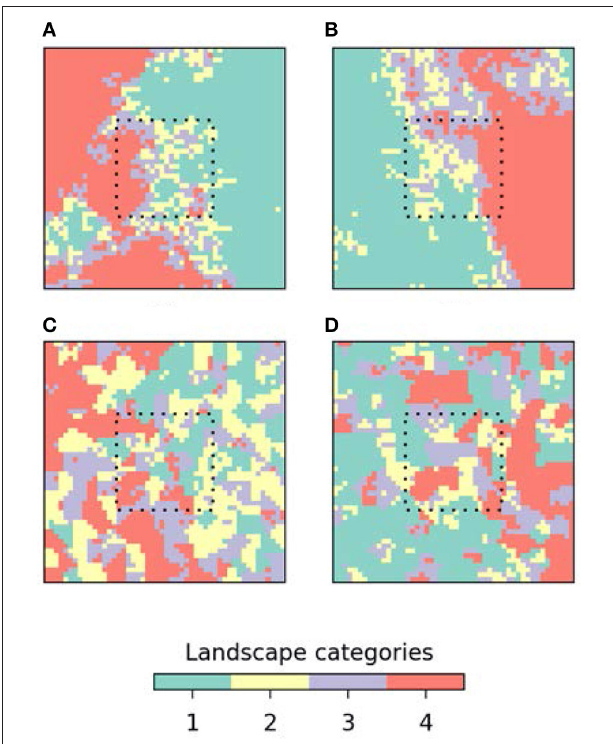
FIGURE 2 | Examples of neutral landscape models of prehistoric landscapes for a hypothetical pollen record indicating four landscape categories. (A,B) Different realizations of naturalistic landscapes in which landscape categories are an ordered sequence resulting from a natural environmental gradient. (C,D) Different realizations of human-influenced landscapes in which the original naturalistic gradient patterns have been modified by discrete patches representing localized human disturbance. In all cases the landscape category proportions within the hypothetical pollen catchment area (dotted line) are equally divided amongst the four categories, while the landscape proportions beyond the pollen catchment area vary individually as part of a broader but consistent spatial pattern to represent uncertainty about landscape patterns beyond the pollen catchment area.